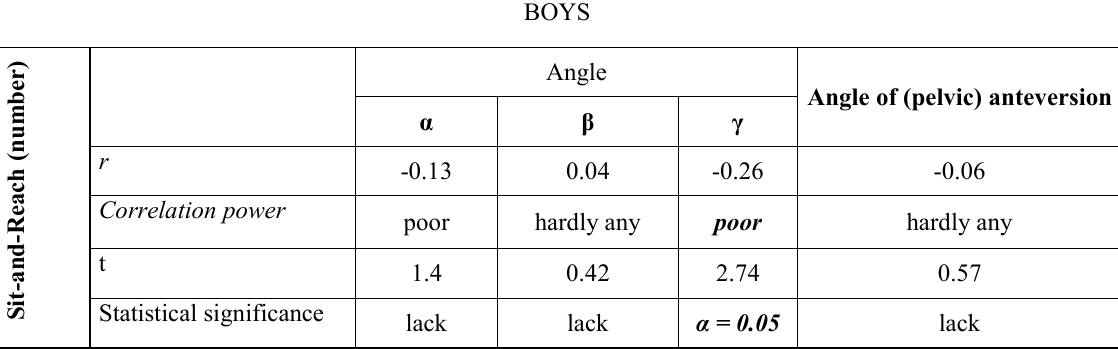
Correlations occurring between the angles characteristic of anterior-posterior pelvic tilts (upper thoracic - α, thoracic- lumbar - β, sacral-lumbar γ) and the angle of pelvic anteversion in the sagittal plane and the sit-and-reach test in the boys involved in the